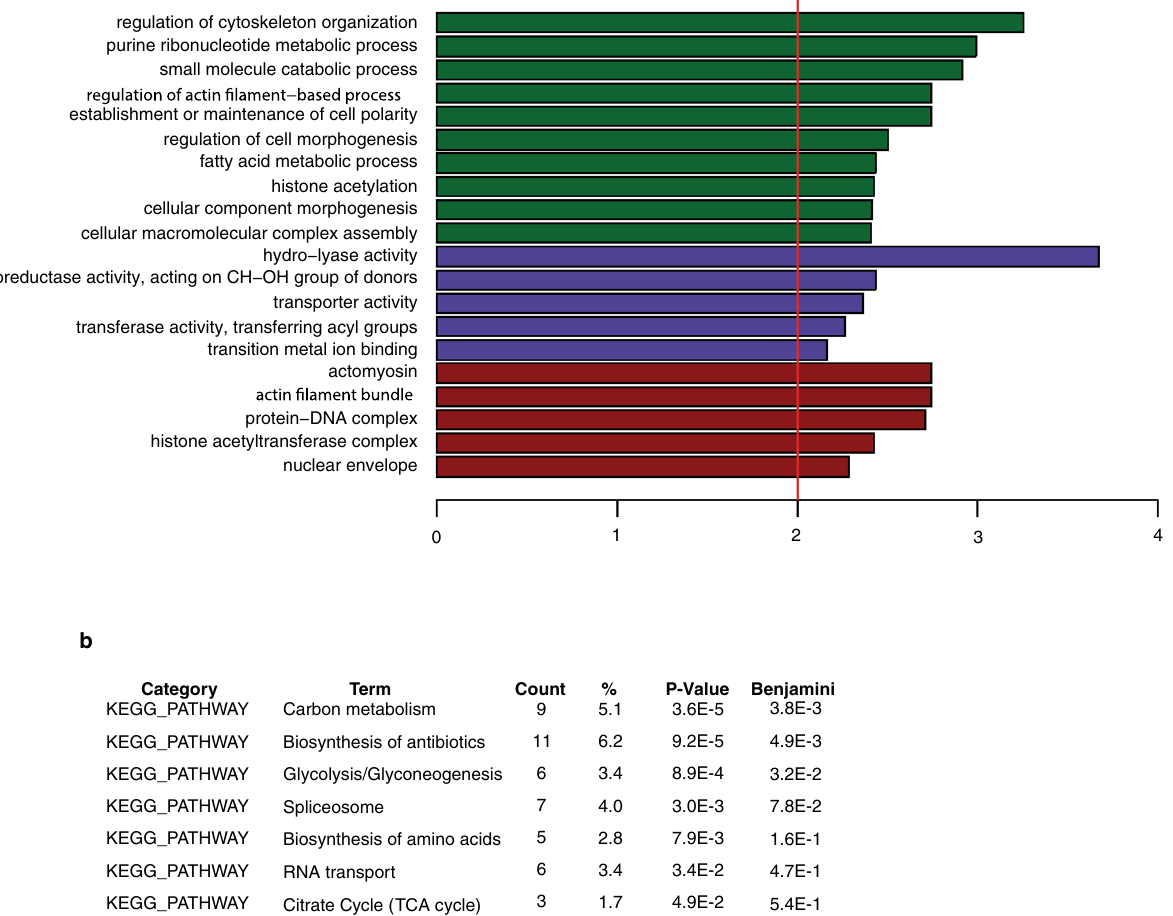
Figure 3. Gene Ontology (GO) Elite and KEGG pathway enrichment analysis of SIRT2 target proteins reveals diverse cellular processes and functions. ( a , b ) GO Elite classification and KEGG pathway enrichment analysis of acetylated proteins both upregulated 1.5-fold following SIRT2 knockdown and downregulated 1.5-fold following SIRT2